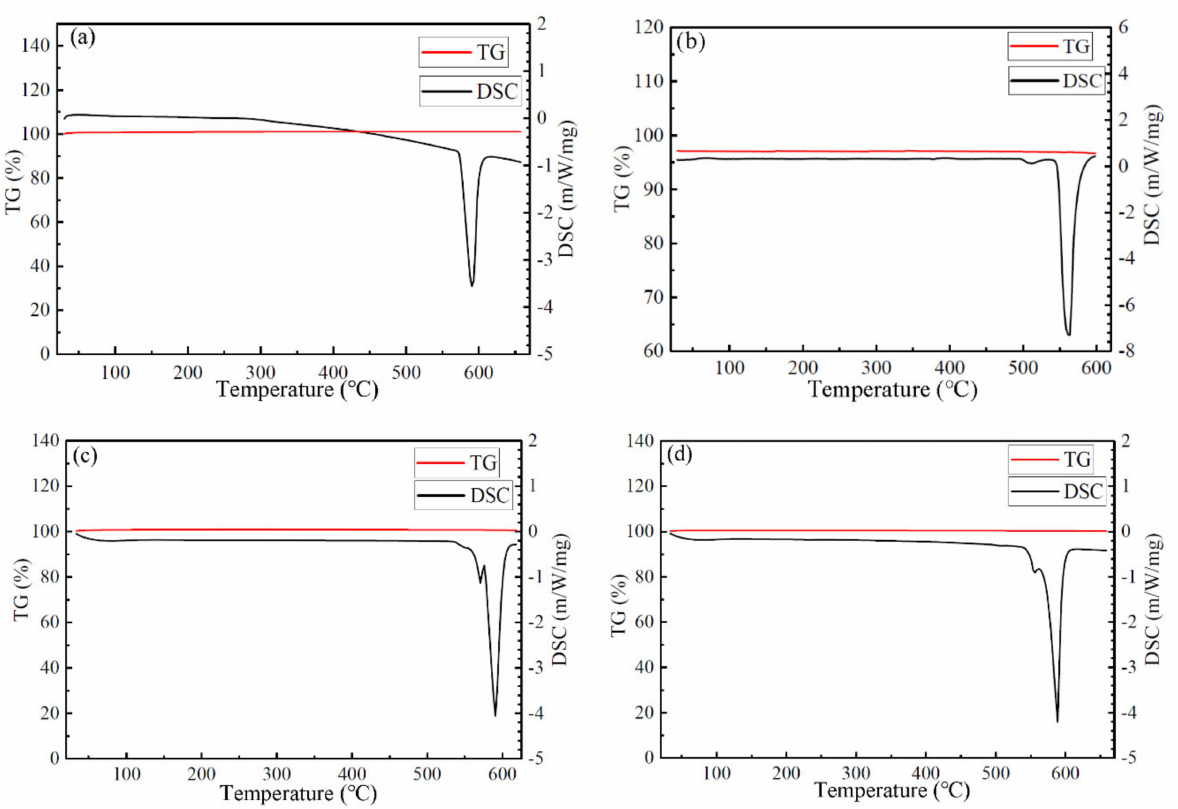
Figure 5. DSC–TG curves: ( a ) Al-12Si alloy; ( b ) Flux; ( c ) The SKA brazing filler metal; ( d ) The PM brazing filler